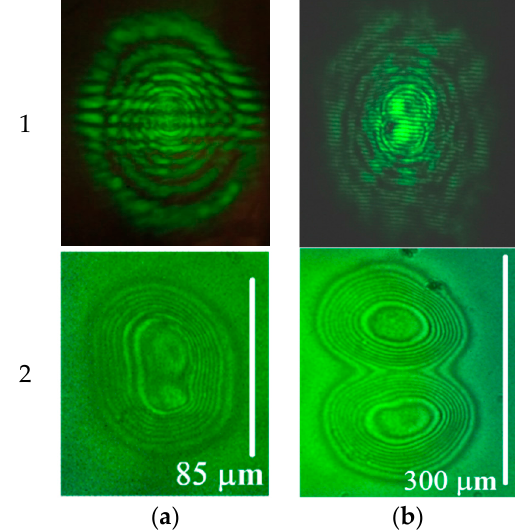
Figure 3. Steady-state aberrational patterns for the normal ( α = 0 ◦ ) light incidence (row “1”) and corresponding microphotographs (row “2”) obtained for normalized beam power δ = ( a ) 5.3 and ( b ) 10.6. The cell position is shifted from the focal plane by ( a ) 1 mm ( d = 18 µ m) and ( b ) 5 mm ( d = 120 µ m). The aberrational-pattern vertical angular size is ( a1 ) 0.5 and ( b1 ) 0.3 rad. Vertical white bar indicates the size of the recorded phase structure.